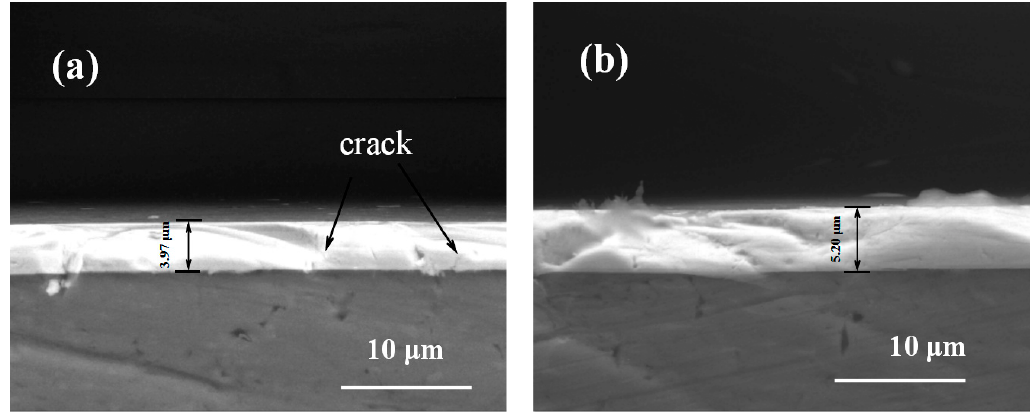
Figure 3. The cross-sectional SEM of coated Ti6Al4V samples of (a) Ta x O y and (b) ZnO-Ta x O y .